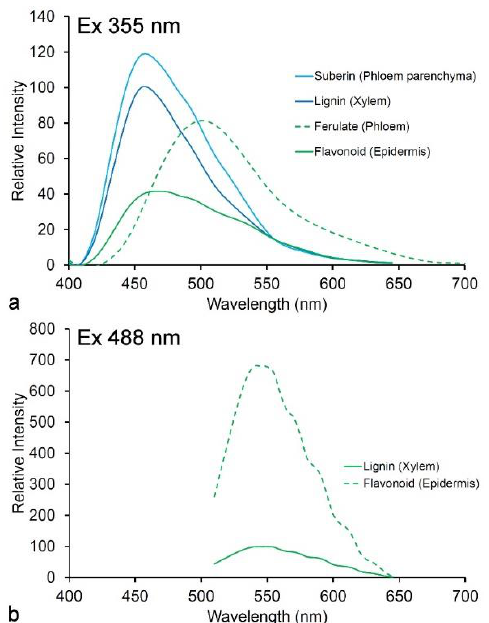
Figure 6. Fluorescence spectra of cell wall autofluorescence in pine needles showing relative brightness. ( a ) Excitation at 350 nm (UV); ( b ) excitation at 488 nm (blue). Flavonoids in the epidermis are much more fluorescent with blue excitation relative to lignin [15].